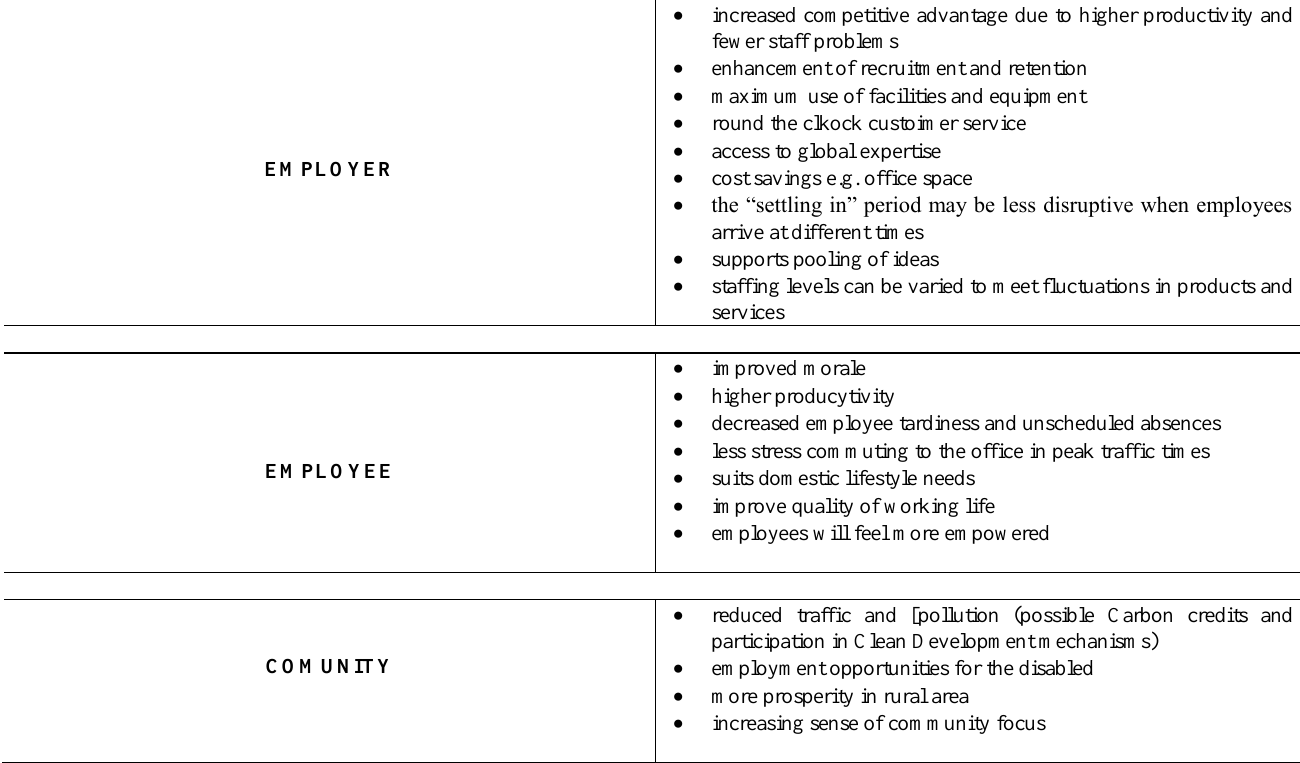
Table 2: Benefits of implementing flexible work practices for the employer, the employee and the community at large